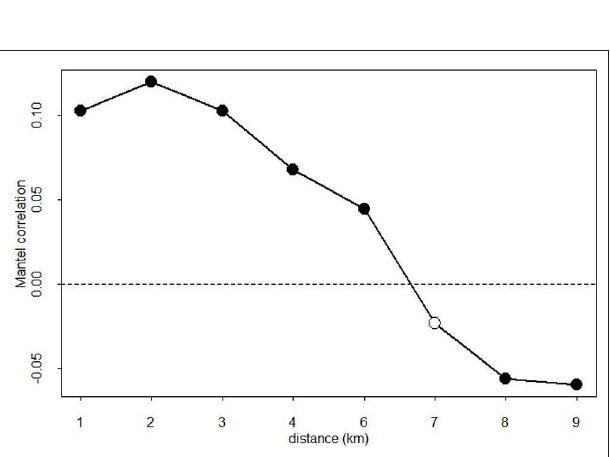
FIGURE 4 | Mantel correlogram of pine processionary moth defoliation data. The x axis shows distance between sites. Filled symbols indicate significant ( P < 0.05) Mantel correlation